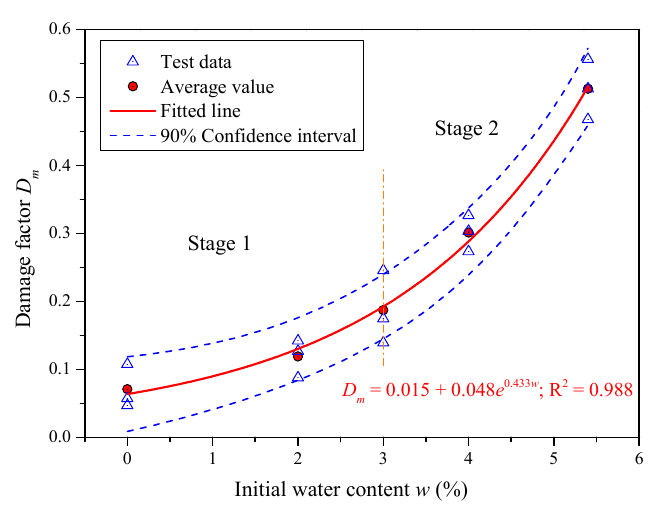
Figure 15. Damage factor vs. initial water content for microwave irradiated sandstone.